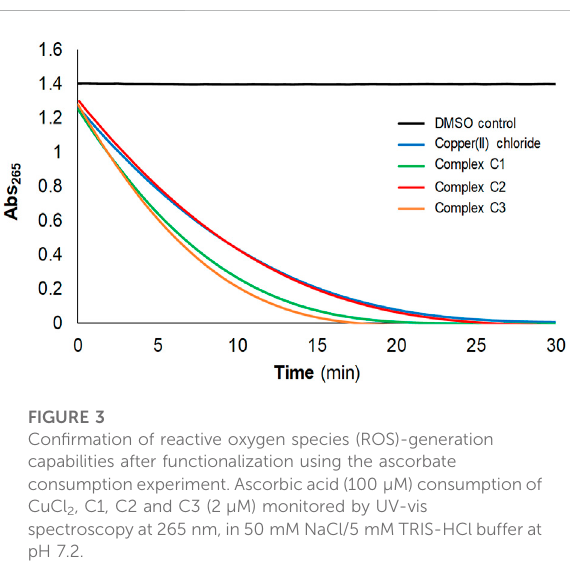
FIGURE 3 Con fi rmation of reactive oxygen species (ROS)-generation capabilities after functionalization using the ascorbate consumption experiment. Ascorbic acid (100 µM) consumption of CuCl 2 , C1, C2 and C3 (2 µM) monitored by UV-vis spectroscopy at 265 nm, in 50 mM NaCl/5 mM TRIS-HCl buffer at pH 7.2.